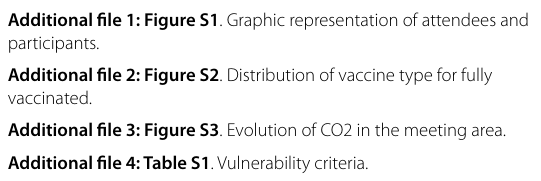
Additional file 2: Figure S2 . Distribution of vaccine type for fully vaccinated. Additional file 3: Figure S3 . Evolution of CO2 in the meeting area. Additional file 4: Table S1 . Vulnerability